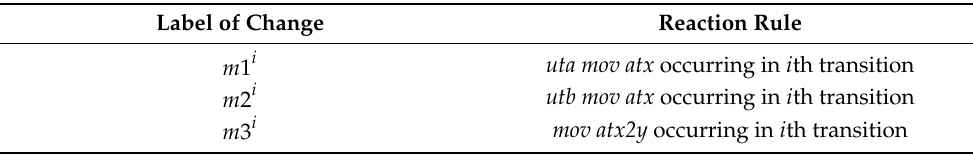
Table 3. Mapping of labels in the state space to reaction rules in the TTS for scenario 1. Label of Change